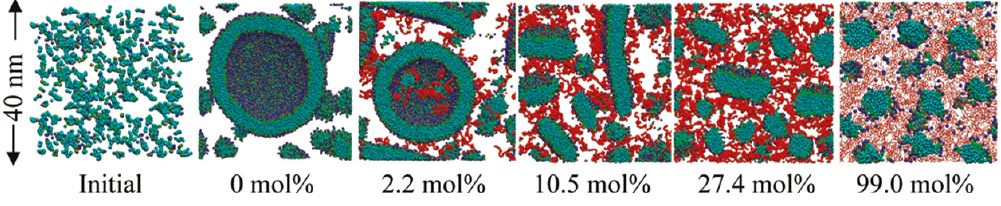
Figure 1. Snapshots at the beginning (0 ns, left) and end (300 ns, columns 2, 3, 4, 5, and 6) of simulations with 0 − 99 mol % PEGylated lipids. Initial configuration is shown only for a simulation with 0 mol %, but this random configuration is applied for initial configurations of all other simulations. Blue, green, and light blue dots respectively represent head groups, glycerols, and tail groups of the lipid, and red dots represent PEG chains. (Reprinted with permission from [44]. Copyright 2013 American Chemical